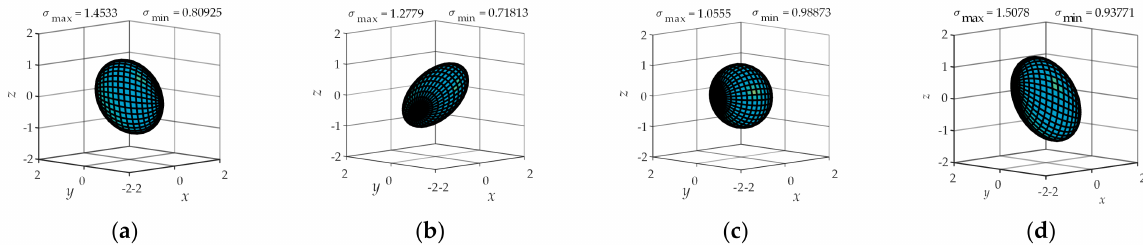
Figure 21. Manipulability ellipsoid of 5 R a 1 P in the horizontal plane. ( a ) α = 30 ◦ ; ( b ) α = 60 ◦ ; ( c ) α = 90 ◦ ; ( d ) α = 120 ◦ .